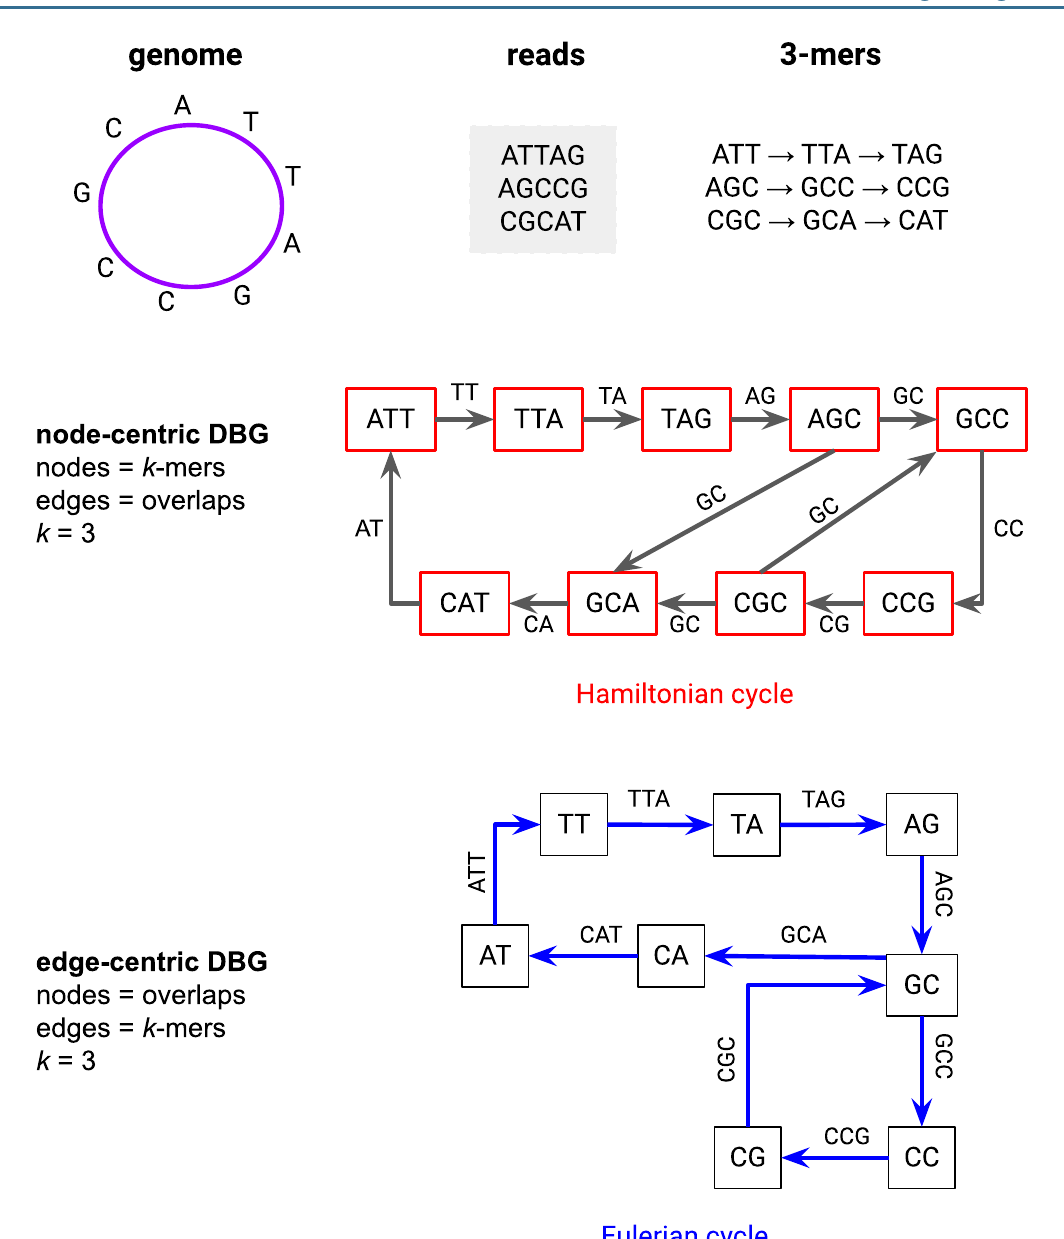
Figure 3 – Overview of genome assembly using de Bruijn graphs. A circular genome is assembled based on three reads using node-centric and edge-centric DBGs with k = 3. The node-centric DBG is searched for a Hamiltonian cycle (visiting all nodes), and the edge-centric DBG for an Eulerian cycle (visiting all edges). These cycles are represented in blue in the